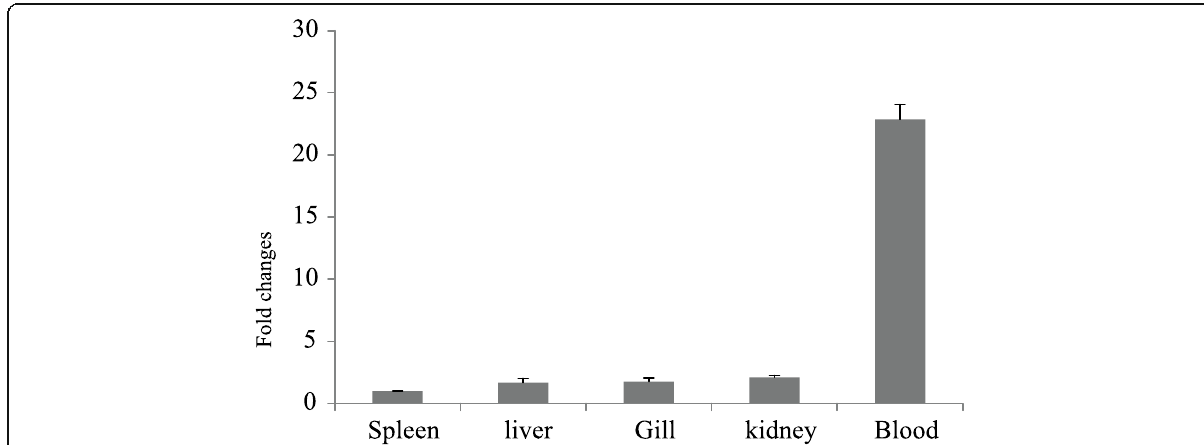
Fig. 5 Tissue-specific caspase-8 gene expression in Labeo rohita. To investigate the tissue-specific expression of caspase-8 gene, total RNA was extracted from the gill, liver, kidney, spleen, and blood of rohu fingerlings and cDNA was prepared. Employing quantitative real-time PCR (qRT- PCR) assay, the cDNA of each tissue sample was analyzed for the expression of caspase-8 and β -actin (housekeeping gene) gene expression. Expression of caspase-8 gene in each tissue was represented as a ratio relative to β -actin levels in the same samples. The spleen was chosen as the calibrator (1), and the relative expression of caspase-8 gene in other tissues was represented as fold changes from the calibrator. The results obtained from three fish were expressed as mean ± standard error (bars in the